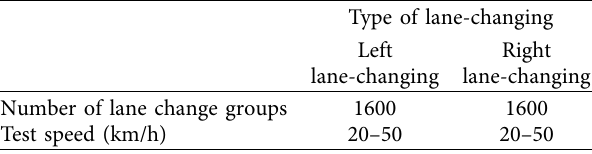
Table 1: Number of test groups and test speed.